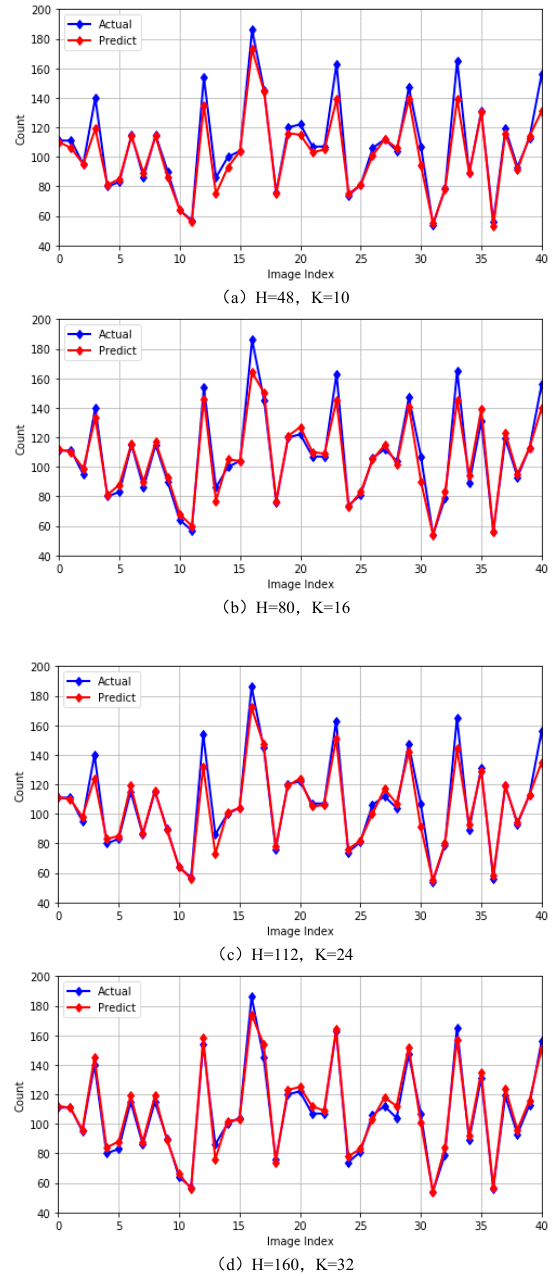
Figure 10. Prediction results with different parameters.